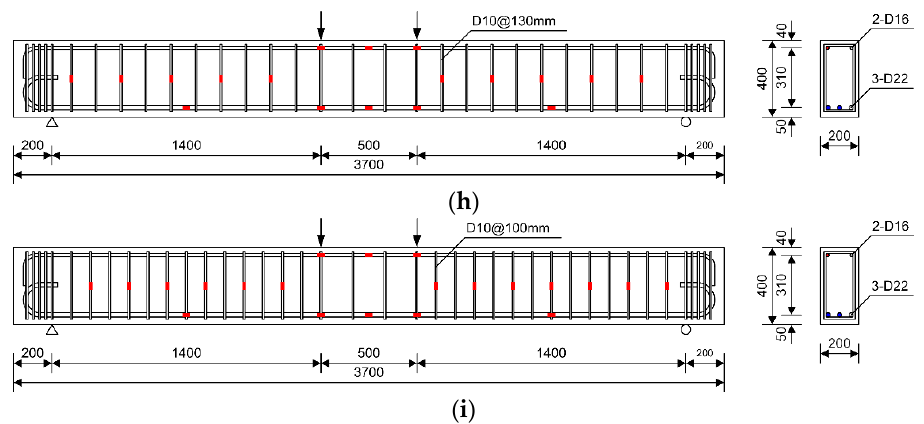
Figure 2. Details of specimens: ( a ) B3-2.5a; ( b ) B3-2.5b; ( c ) B3-2.5c; ( d ) B6-2.5a; ( e ) B6-2.5b; ( f ) B6-2.5c; ( g ) B6-4.0a; ( h ) B6-4.0b; ( i ) B6-4.0c (unit: mm).